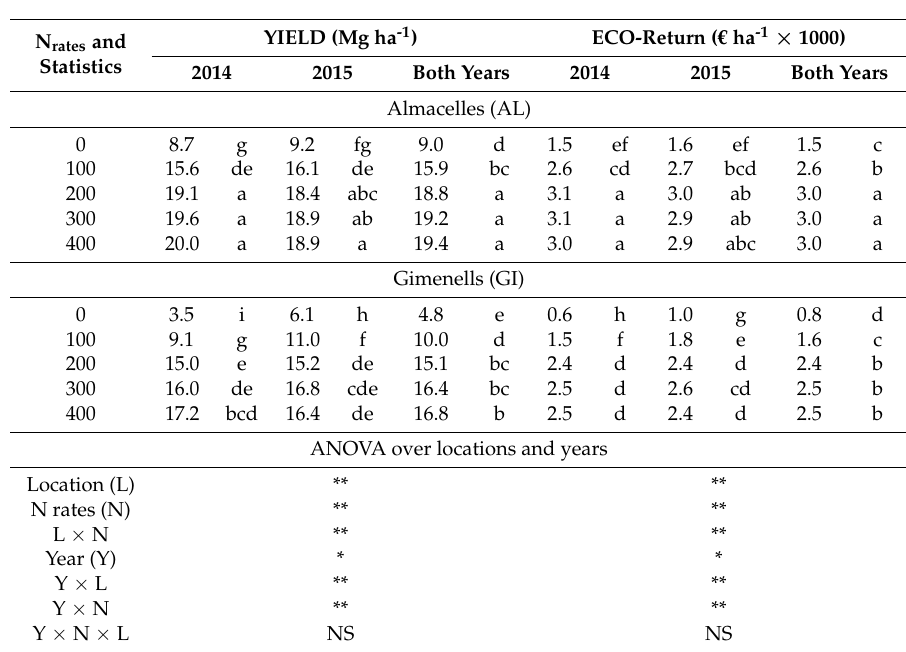
Table 4. Analysis of variance and mean values of yield and economic return (ECO-return) for the different nitrogen rates (N rates ) on the experiments of Almacelles (AL) and Gimenells (GI) during 2014 and 2015. Tukey’s HSD test was performed in 2014 and 2015 (and both years together) for the yields of the both sites (AL and GI): different letters indicate homogeneous groups with respect to the mean differences at a p -value of